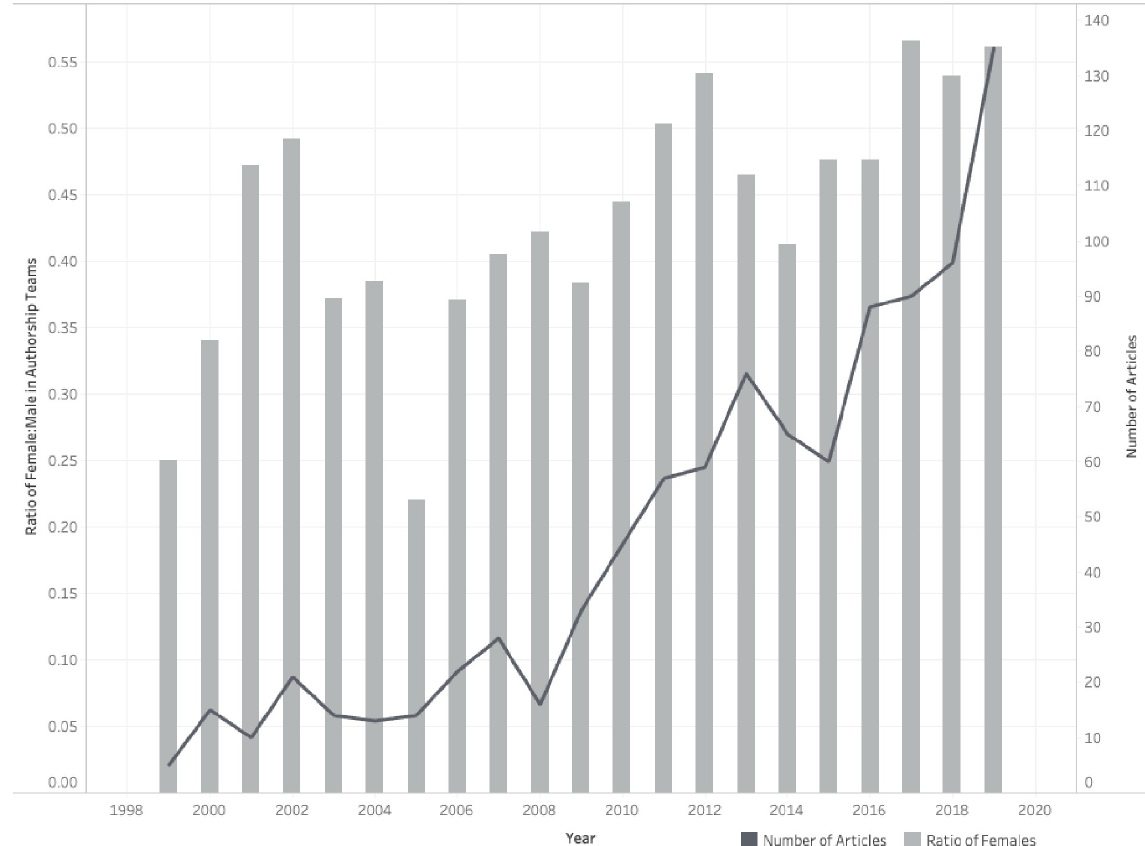
Fig 3. The ratio of female authors in all authorship positions for knowledge syntheses published in 14 core medical education journals published between 1999–2019.